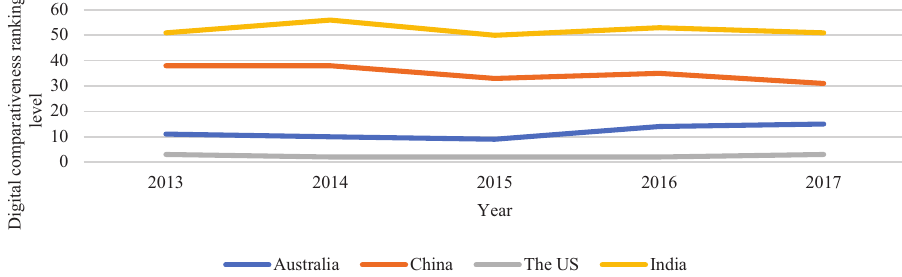
Figure 3. Digital comparativeness ranking in Australia, China, the US and India from 2013 to 2017,